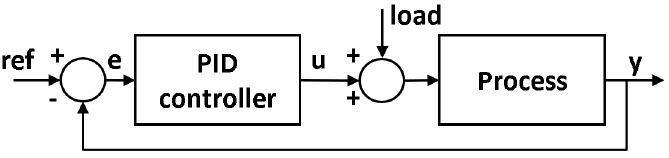
Figure 1. Feedback control system.